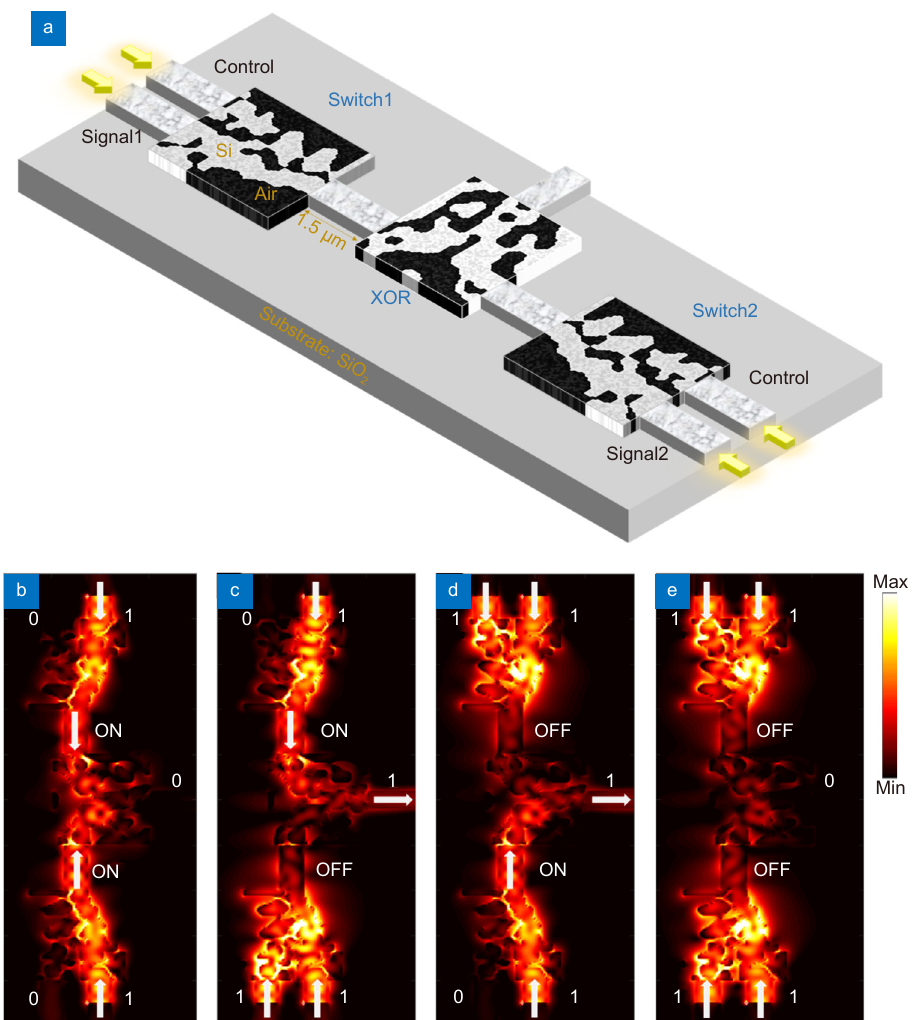
Fig. 6 | Characterization of the all-optical integrated circuit. ( a ) General configuration of the all-optical integrated circuit. ( b ) The “11” input (“ON” and ”ON” states) of normalized intensity distribution in the x - y plane from theoretical calculation. ( c ) The “10” input (“ON” and ”OFF” states) of normalized intensity distribution in the x - y plane from theoretical calculation. ( d ) The “01” input (“OFF” and ”ON” states) of normalized intensity distribution in the x - y plane from theoretical calculation. ( e ) The “00” input (“OFF” and ”OFF” states) of normalized intensity distribution in the x - y plane from theoretical calculation.